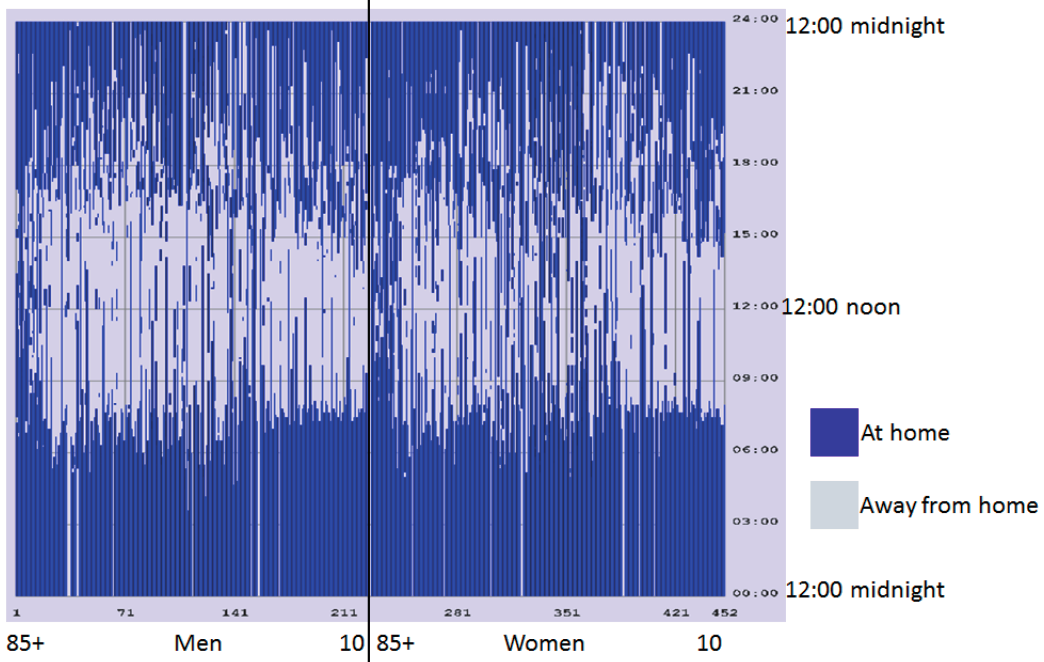
Figure 1. Time spent at home on weekdays based on 452 individual diaries. The day of each individual is shown by a vertical line to be read from bottom to top, i.e. , from midnight to the next midnight, thereby each individual’s sequence of being at home and being away from home during the 24 h of the day is revealed. The individuals are ordered by gender, i.e. , men ( n = 225) to the left and women ( n = 227) to the right, and age, i.e. , the oldest to the left and the youngest to the right among men and women, respectively. The individuals range in age from 10 to 99